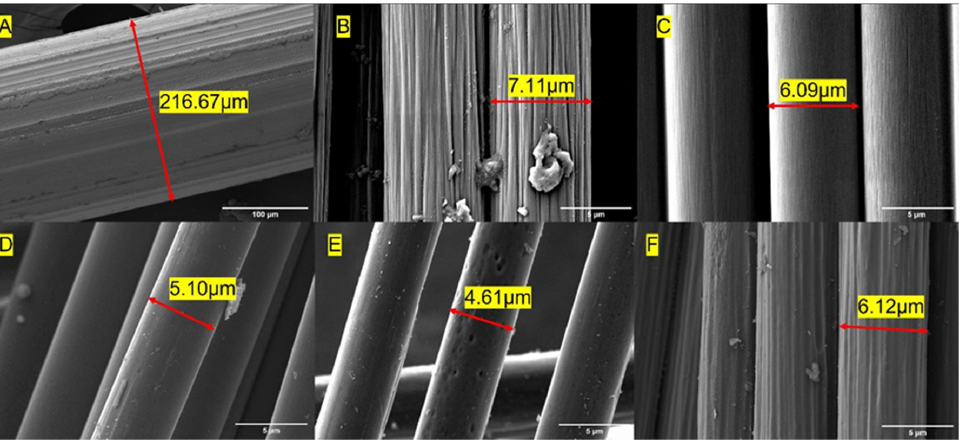
Figure 4. Scanning electron micrographs of ( A ) Steel, ( B ) Zoltek, ( C ) Hexcel, and ( D – F ) recycled carbon fibers showing example fiber diameter measurements.